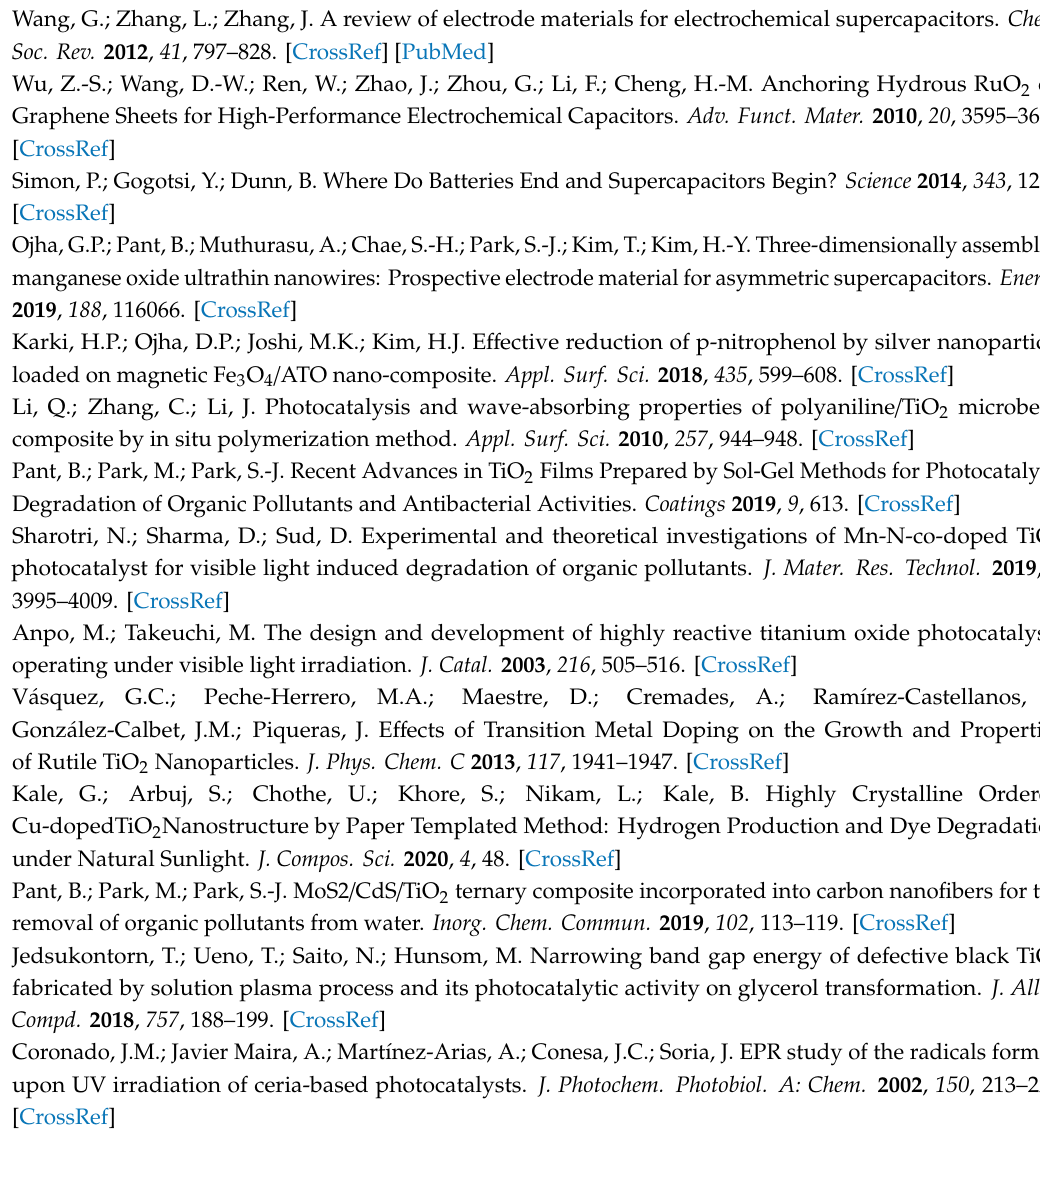
Figure S1: FESEM image of PANi / Mn-TiO 2 (inset shows the EDS profile), Figure S2: Peak current versus square root of scan rates, Figure S3: GCD curves of activated carbon at di ff erent scan rates, Figure S4: Photocatalytic reduction of MB for TiO 2 , Mn-TiO 2 and PANi / Mn-TiO 2 , Table S1: Comparative study of electrochemical performance of